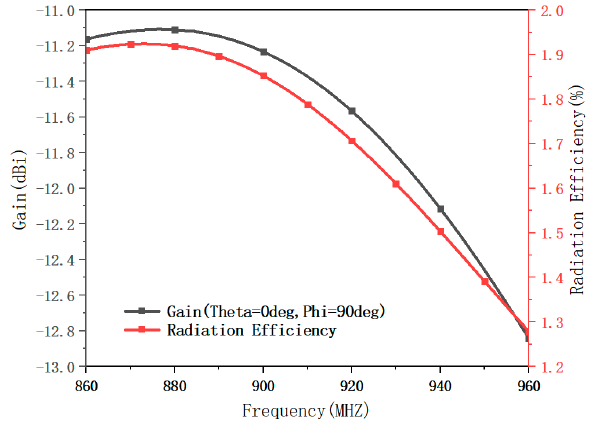
Figure 5. Simulated far-field gain and radiation efficiency of the spiral antenna.